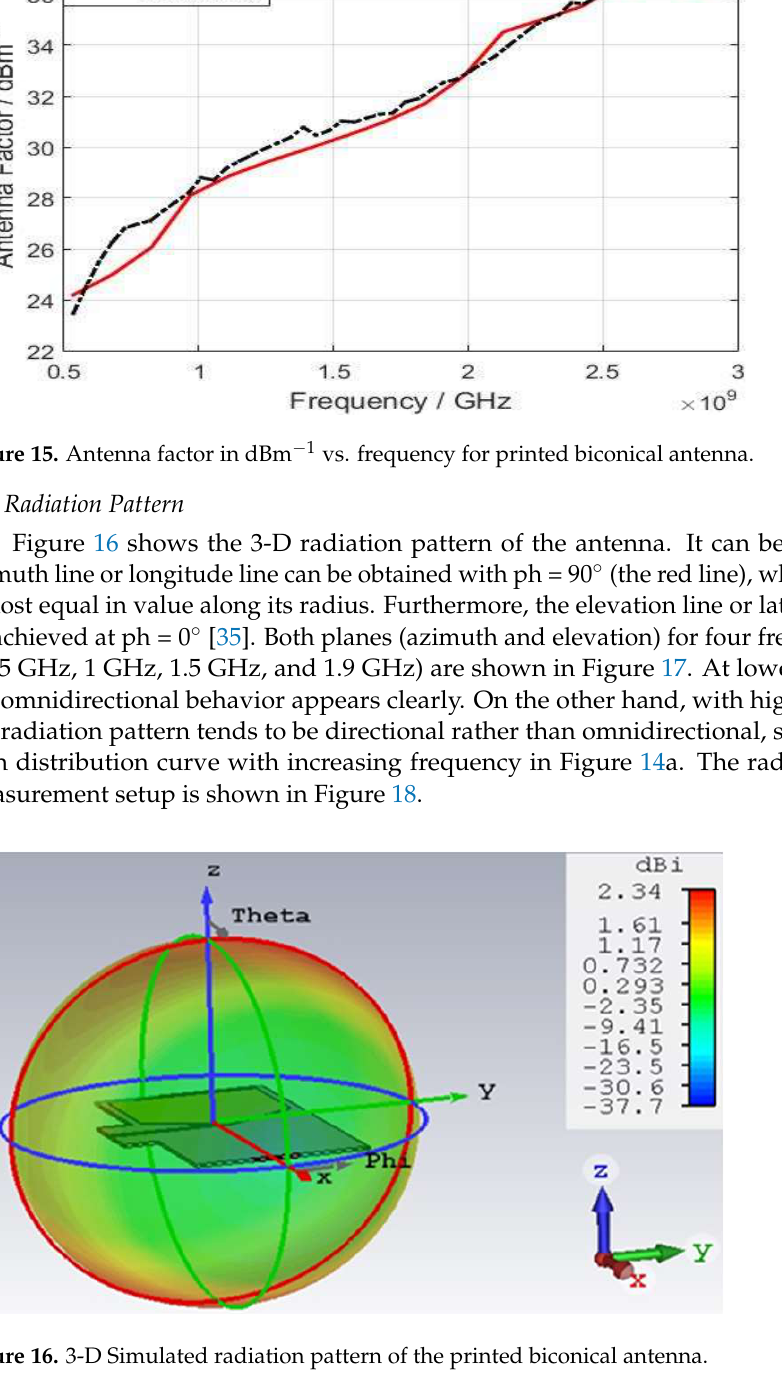
Figure 16. 3-D Simulated radiation pattern of the printed biconical antenna.